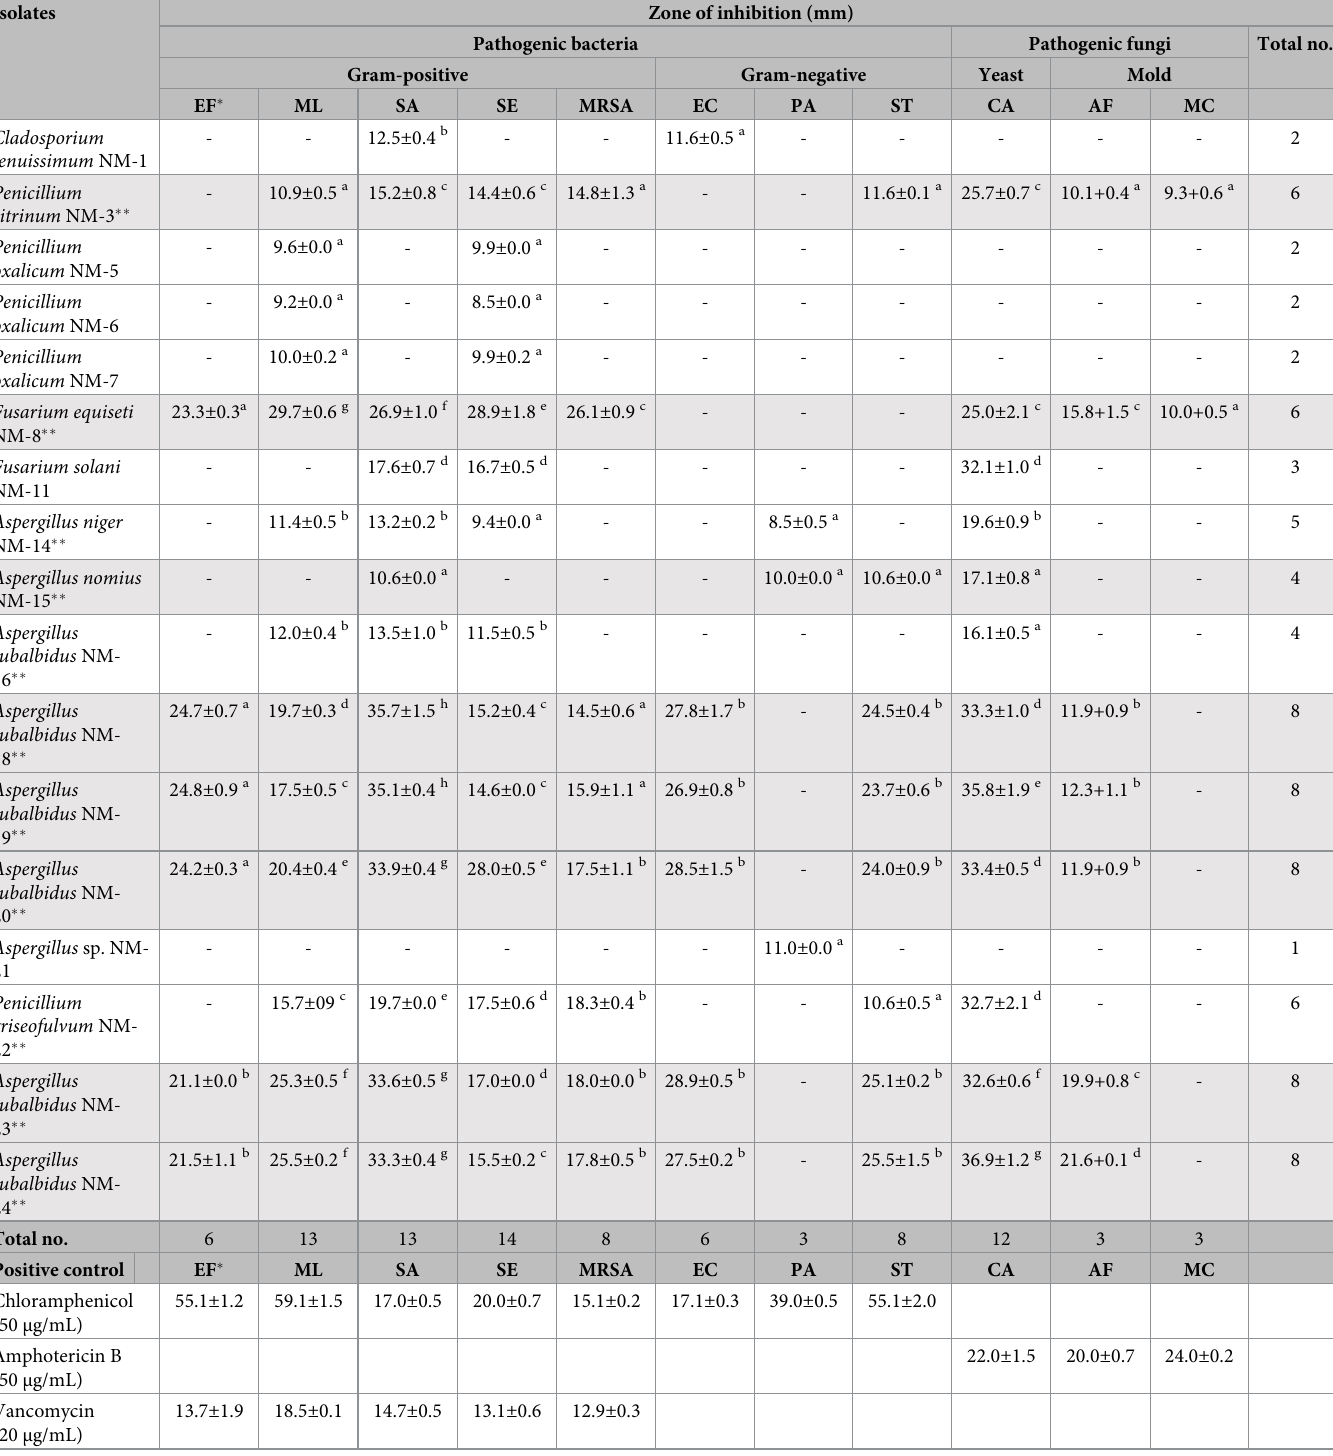
Table 5. Preliminary screening of antimicrobial activity of fungi isolated from salterns in Pattani Province, Thailand, was conducted using the agar well diffusion method.